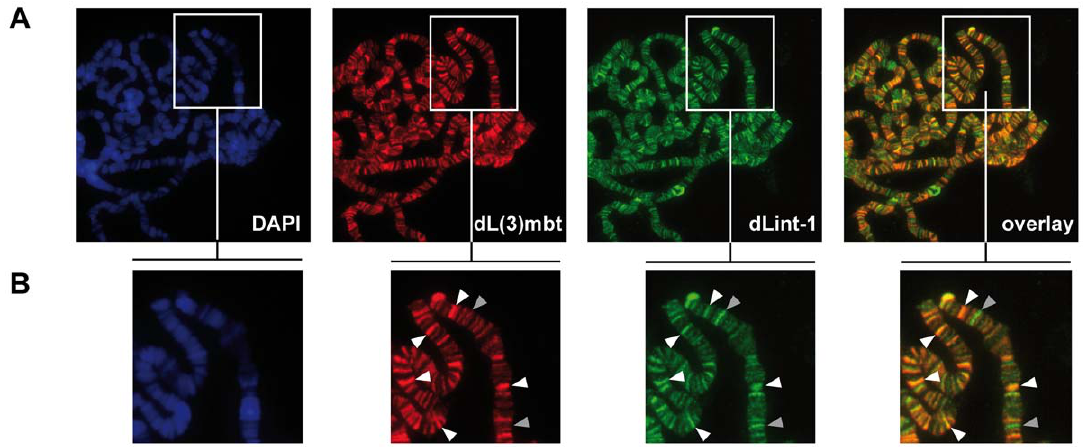
Figure 3. dL(3)mbt and dLint-1 colocalise on polytene chromosomes. (A) Immunofluorescence stainings of polytene chromosomes. Flies carrying an dL(3)mbt transgene under control of UAS were crossed with a salivary gland-specific sgs58AB - GAL4 driver strain. Polytene chromosomes were stained with dL(3)mbt, dLint-1 antibodies and DAPI as indicated. The right panel shows an overlay of the dL(3)mbt and dLint-1 staining. (B) Magnified sections of the panels shown in (A). White and grey arrow heads denote selected prominent sites of colocalization (white) and exclusive dLint-1 binding sites (grey), respectively.